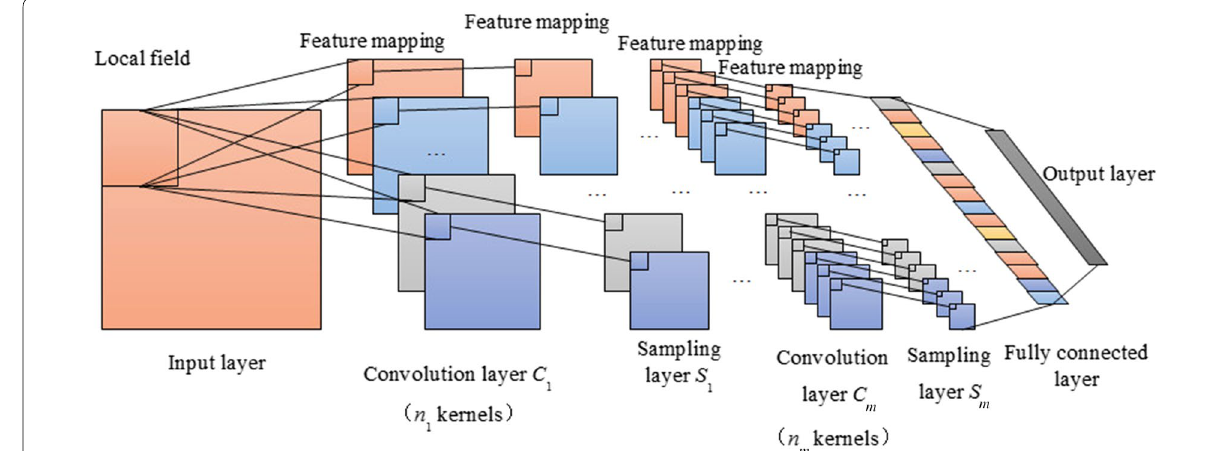
Figure 7 Architecture of convolutional neural network (CNN)